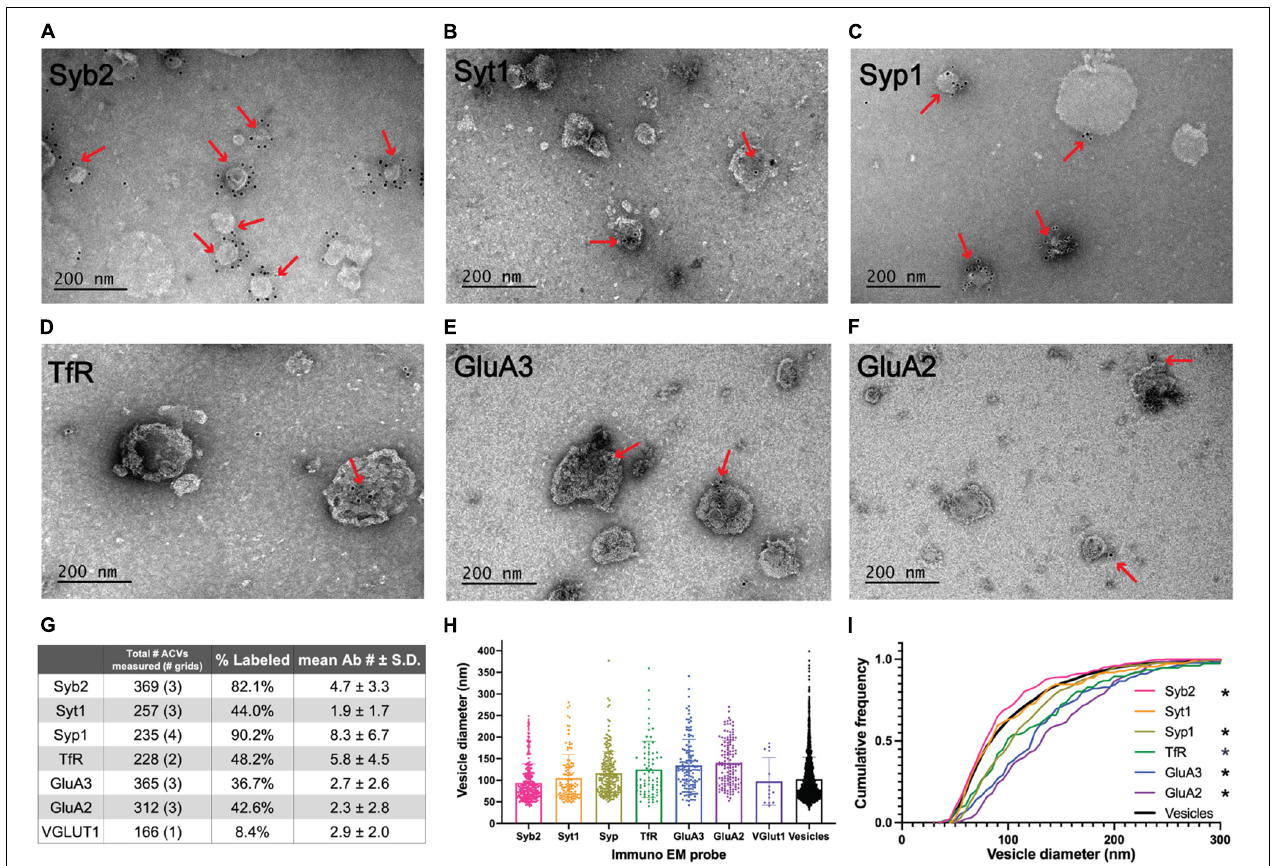
FIGURE 2 | Electron microscopy analysis of ACV samples. (A–F) Immuno-negative stain electron micrographs for GluA2, GluA3, Syb2, Syt1, TfR, and Syp1. Red arrows indicate regions with gold-conjugated secondary antibody. (G) Summary table of negative stain electron microscopy analysis of antibody labeled preparations of GluA1 peptide eluate of wild-type mice. Total number of ACVs represents all ACVs measured for the given probe. Each grid represents an independent preparation and imaging experiment (all images are provided as Source Data). (H) Mean and standard deviations of diameters of vesicles labeled with each antibody. (I) Normalized cumulative frequency distributions of diameters of vesicles labeled with each antibody. The bold line represents the frequency distribution of all vesicles from Figure 1D . The Kolmogorov–Smirnov test was performed to test statistical significance between an independent population of vesicles from Figure 1D and vesicles containing Syb2 ( p = 0.0101), Syt1 ( p = 0.9382), Syp1 ( p < 0.0001), TfR ( p = 0.0100), GluA2 ( p < 0.0001), and GluA3 ( p < 0.0001). *Indicates p -value < 0.05.